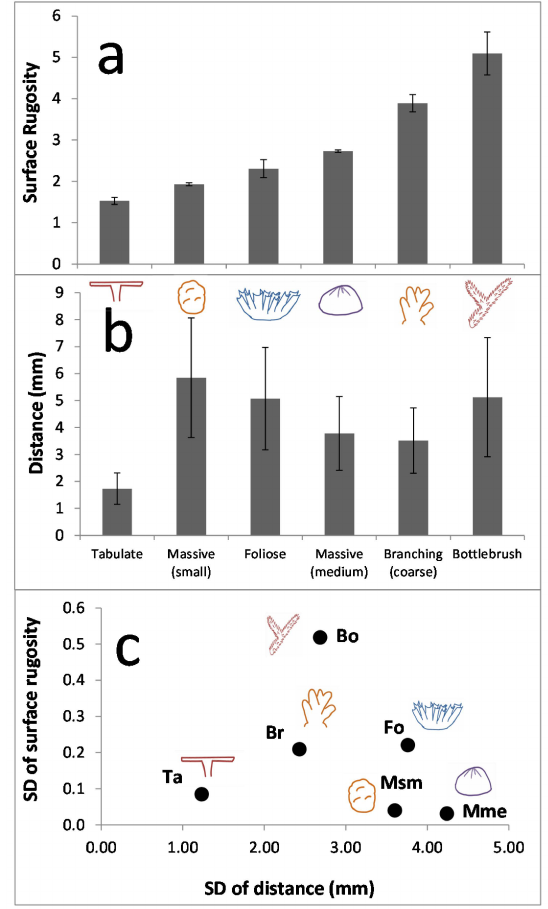
Figure 3. Precision analysis of photogrammetrically derived 3D models of six morphotypes of coral colony. ( a ) Average (+/ ´ SD) surface rugosity values for each morphology; ( b ) average (+/ ´ SD) distance between all replicate models for each morphology based on comparison of 3D geometry; ( c ) comparisons of 3D geometry error (SD, x -axis) versus estimated surface rugosity error (SD, y -axis). Bb, Bottlebrush; Br, Branching-coarse; Fo, Foliose; Mme, Massive-medium; Msm, Massive-small; Ta,